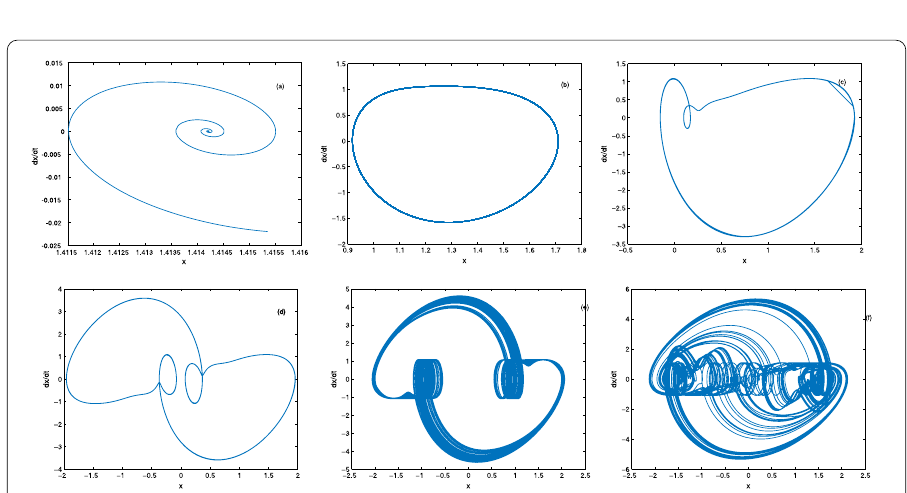
Figure 9 The phase plane plot in x – dx / dt space for different τ : ( a ) τ = 0.25 (stability), ( b ) τ = 0.45 (period-1), ( c ) τ = 0.65 (period-2), ( d ) τ = 0.68 (period-4), ( e ) τ = 0.77 (chaos), ( f ) τ = 0.83 (chaos) with parameter γ = 2